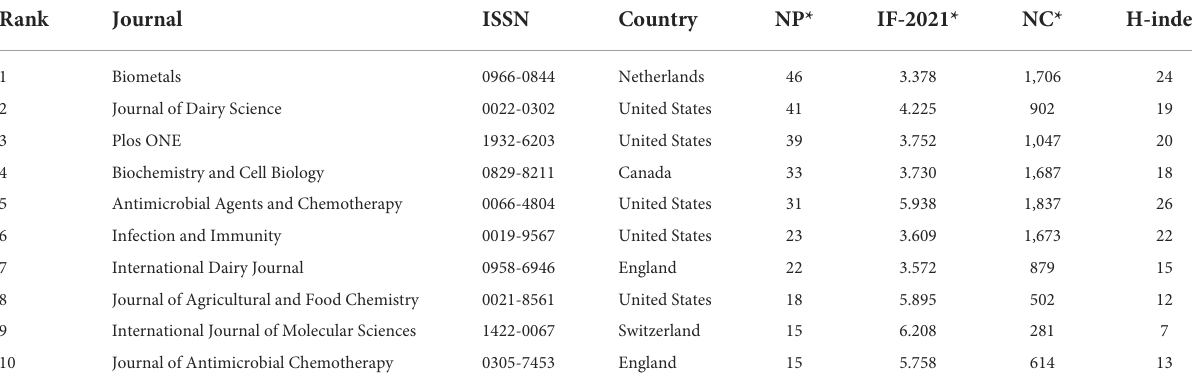
TABLE 4 Top 10 most productive journals in the field of LF immunomodulatory of research.